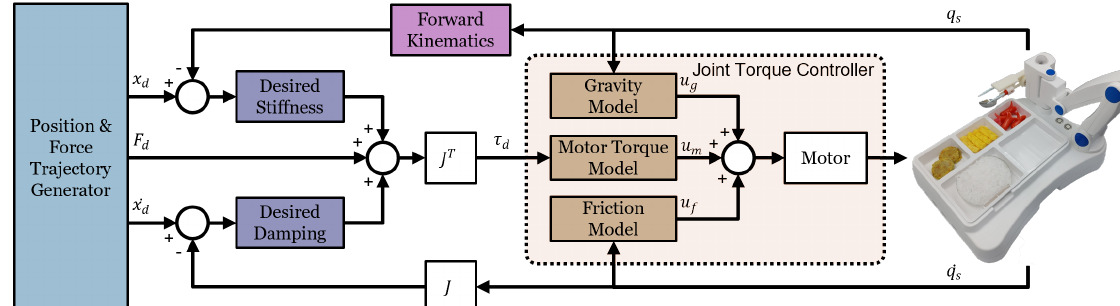
Figure 5. The control schematic for the MAR’s motion